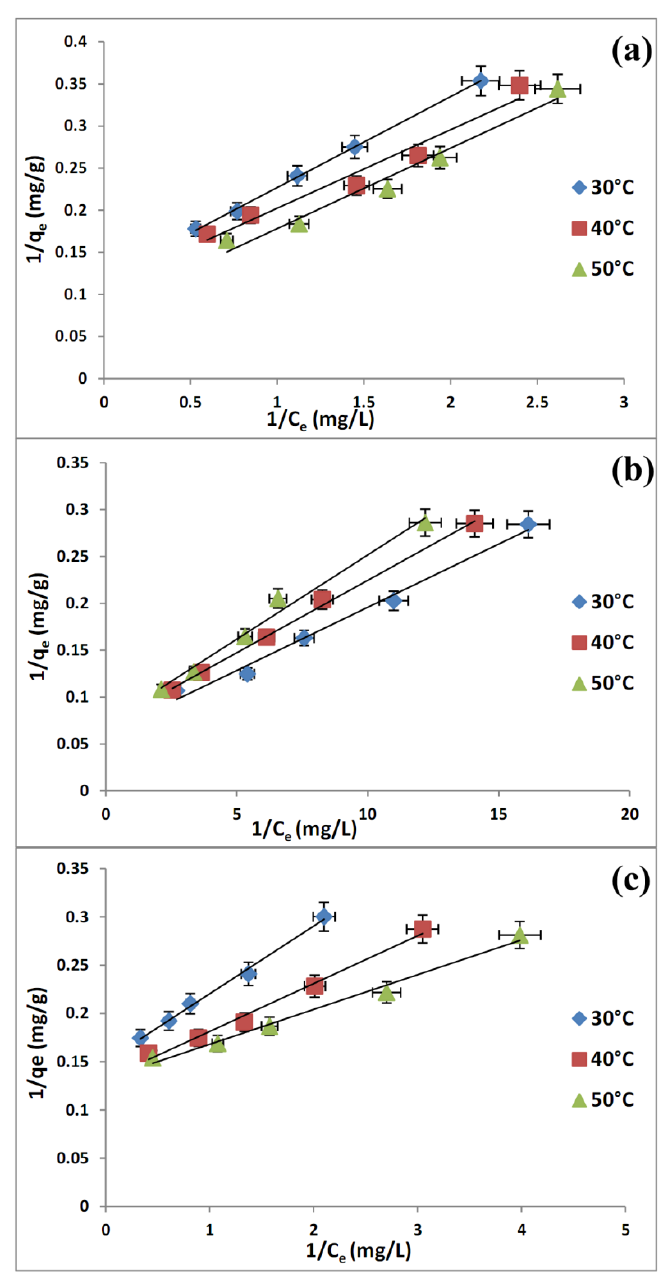
Figure 8. Langmuir isotherm of TBT adsorbed onto MCM-TDI-C4 ( a ), MCM-TDI-PC4 ( b ) and MCM-TDI-C4S ( c